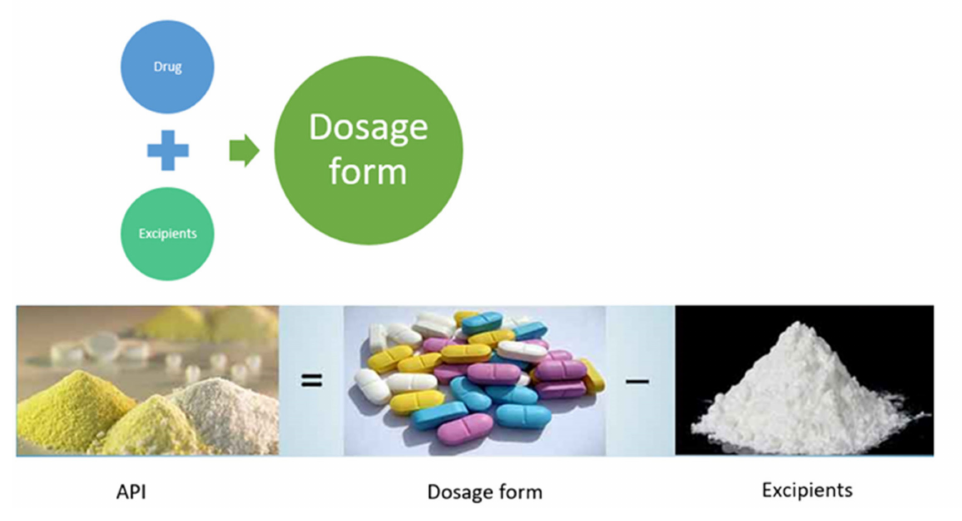
Figure 1. Dosage form